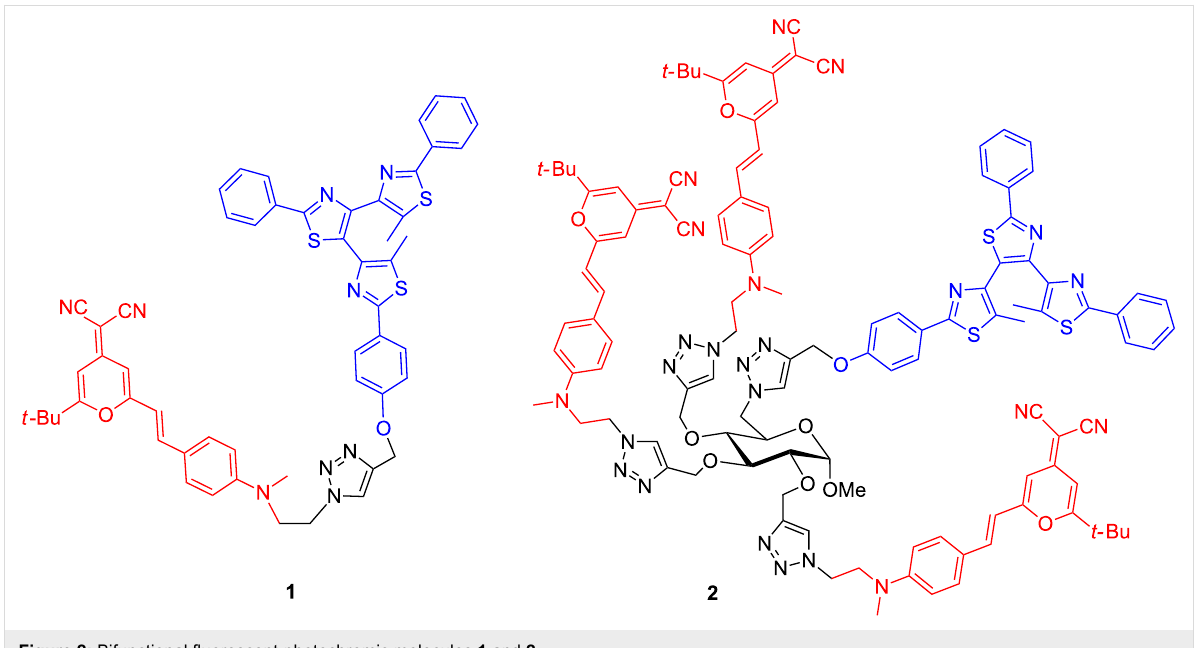
Figure 2: Bifunctional fluorescent-photochromic molecules 1 and 2 .